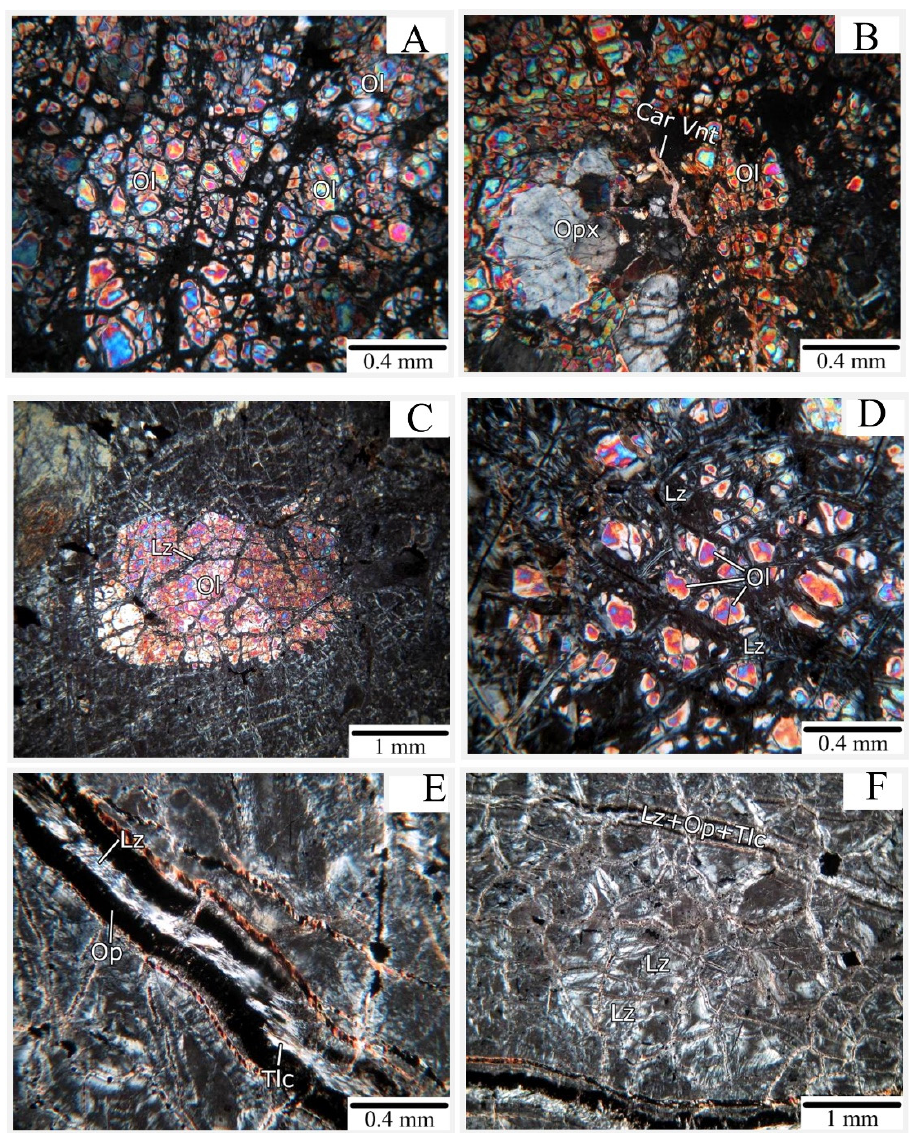
Figure 9. The microscopic (transmitted-light) images of samples taken from the ultramafic section of ophiolite with different degrees of serpentinization. ( A , B ) The weakly serpentinized harzburgite comprises olivine and orthopyroxene. ( C , D ) The moderately to highly serpentinized harzburgite showing mesh structures for olivine and serpentine minerals (mainly lizardite). ( E , F ) Serpentinite with unknown protolith comprises lizardite, talc, and veinlet filled by opaque minerals (probably altered chromite). The abbreviation of minerals is Lz (Lherzolite), Tlc (Talc), Ol (Olivine), Opx (Orthopyroxene), and Op (Opaque minerals). The Car Vnt denotes the veinlets filled by carbonate minerals. All photomicrographs were taken under cross-polarized light (XPL). The dykes which crosscut the ultramafic units (including both depleted harzburgites/dunites) based on their mineralogy vary from diabase, gabbro to norite, and